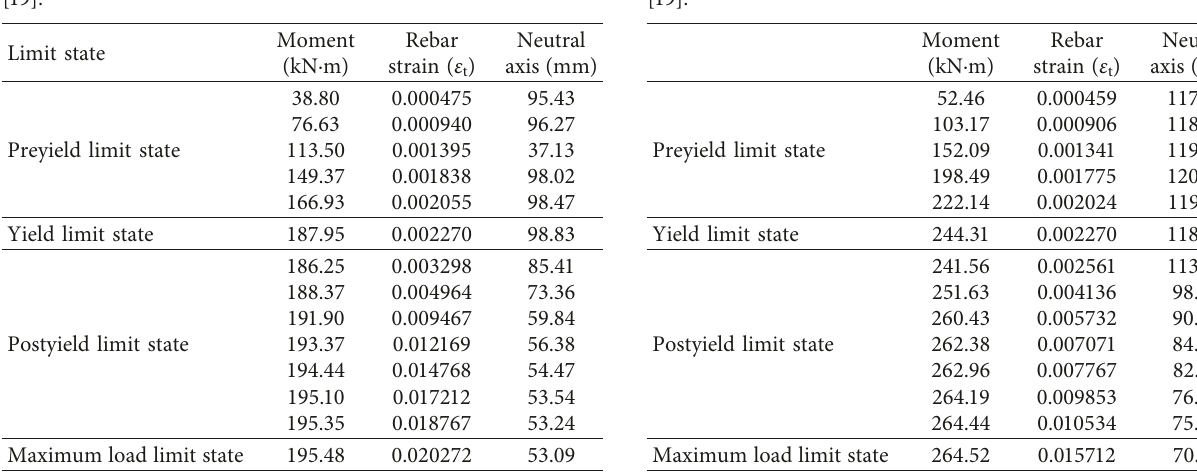
Table 10: Analytical moment-strain relationship (Specimen #2)